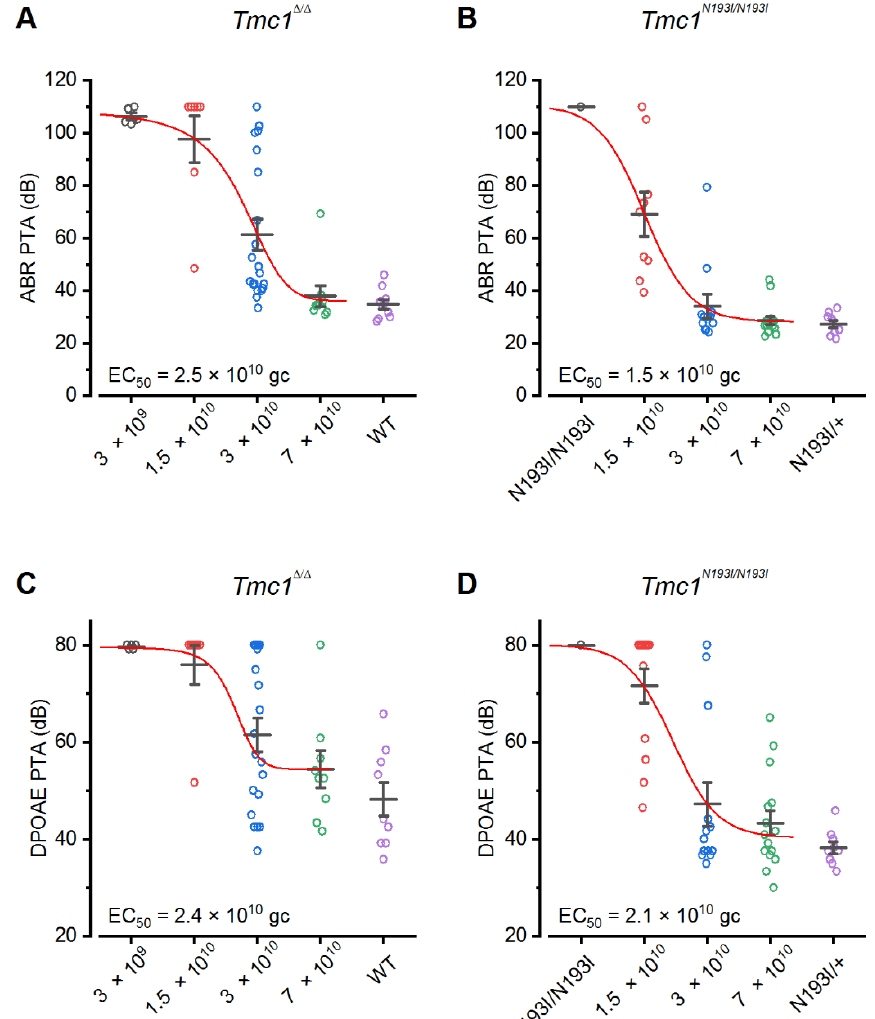
Figure 4. Dose–response curve of the AAV2/9-PHP.B -CB6-hTMC1 + WPRE gene therapy construct. Pure tone average (PTA) ABR ( A , B ) or DPOAE ( C , D ) thresholds of Tmc1 ∆ / ∆ ( A , C ) or Tmc1 N193I/N193I ( B , D ) injected with different doses of CB6-hTMC1 + WPRE (3 × 10 9 gc–7 × 10 10 gc). PTAs from uninjected controls are included in the plots for comparison.